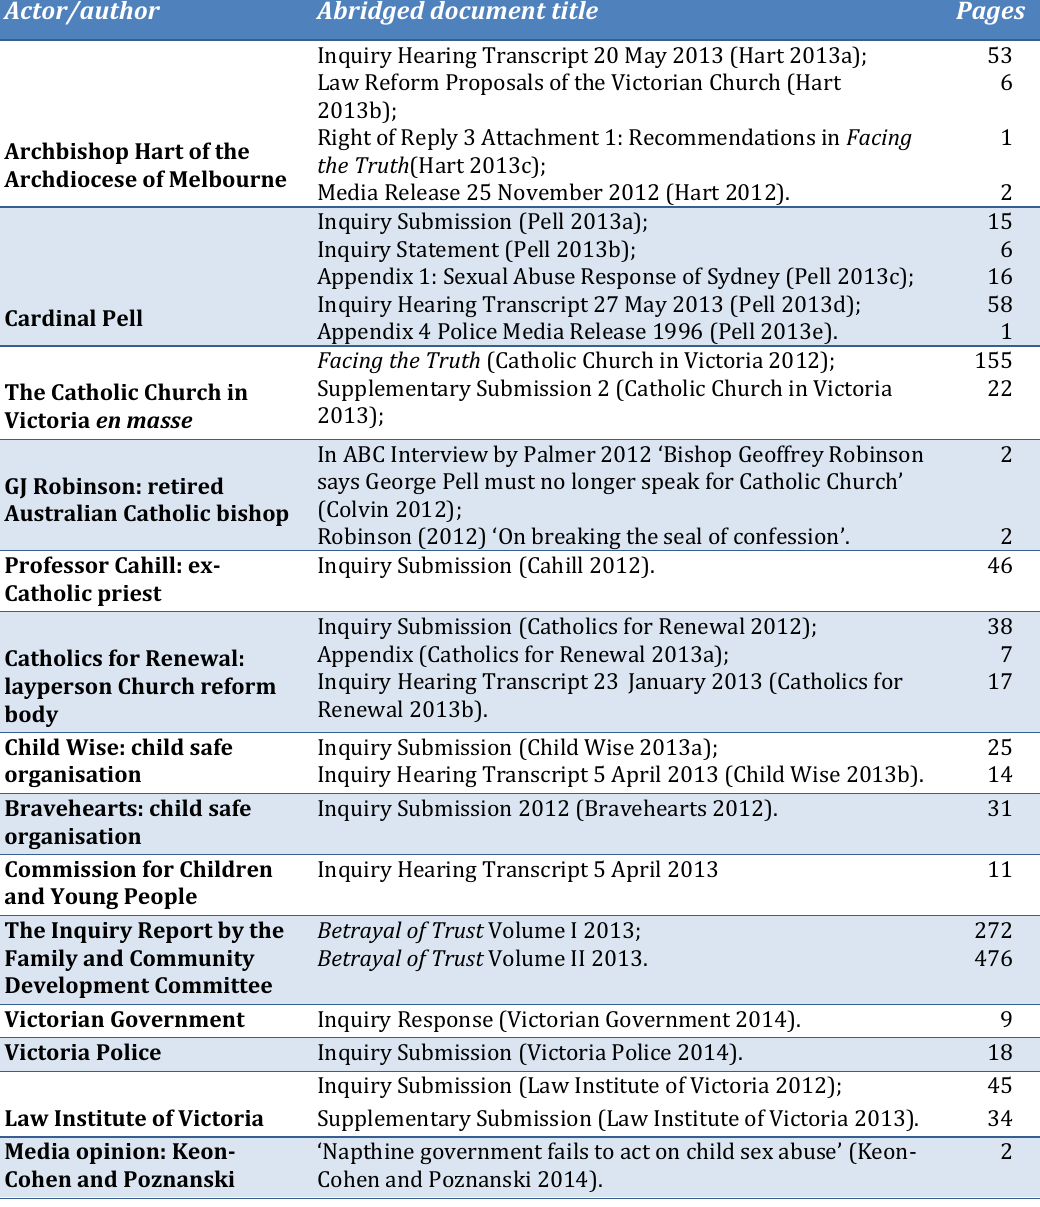
Table 1: The research